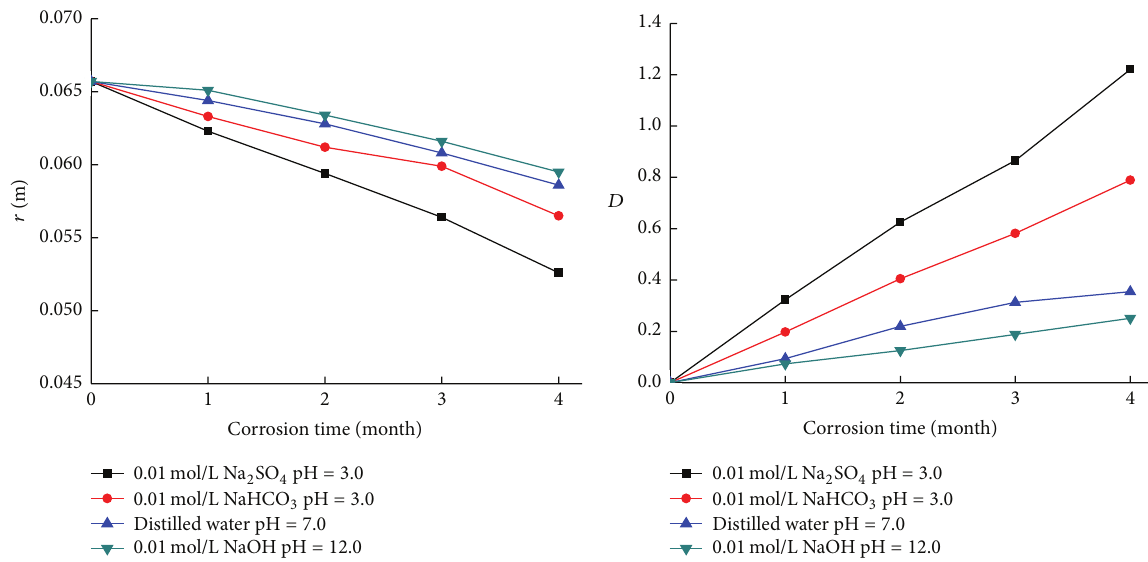
Figure 9: Relationships between crack propagation radii, damage variable of granite specimens, and corrosion time under different water chemical